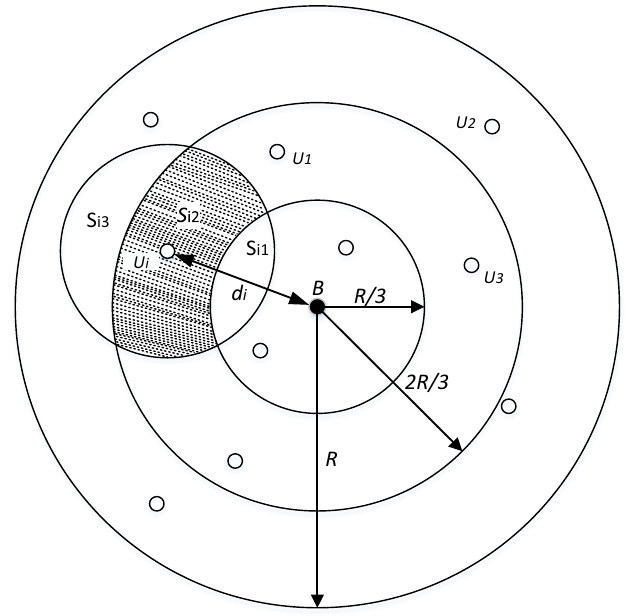
Figure 3. Diagram of virtual partition algorithm.